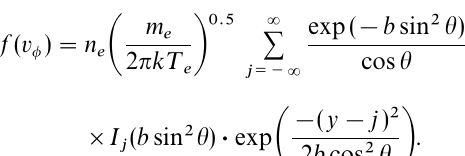
Fig. 1. Model photo elec- tron and auroral electron fluxes for 120, 160 and 250 km altitudes. The photo- electron fluxes have been calculated for high solar activity conditions, f10.7 index " 180. The auroral electron fluxes have been calculated using a 1 keV Maxwellian primary flux of 25 ergs/cm (cid:50)